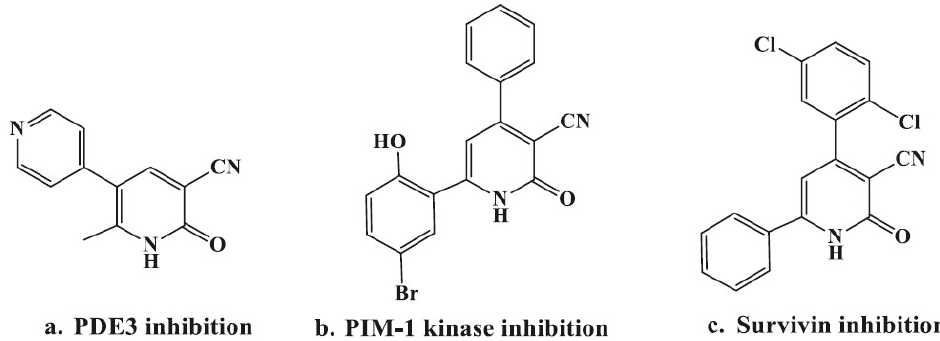
Figure 1. Various 3-cyano-2-oxopyridine derivatives with potential growth inhibitory and/or antiangiogenic actions through PDE3 inhibition ( a ); PIM-1 kinase inhibition ( b ); or survivin inhibition ( c ).